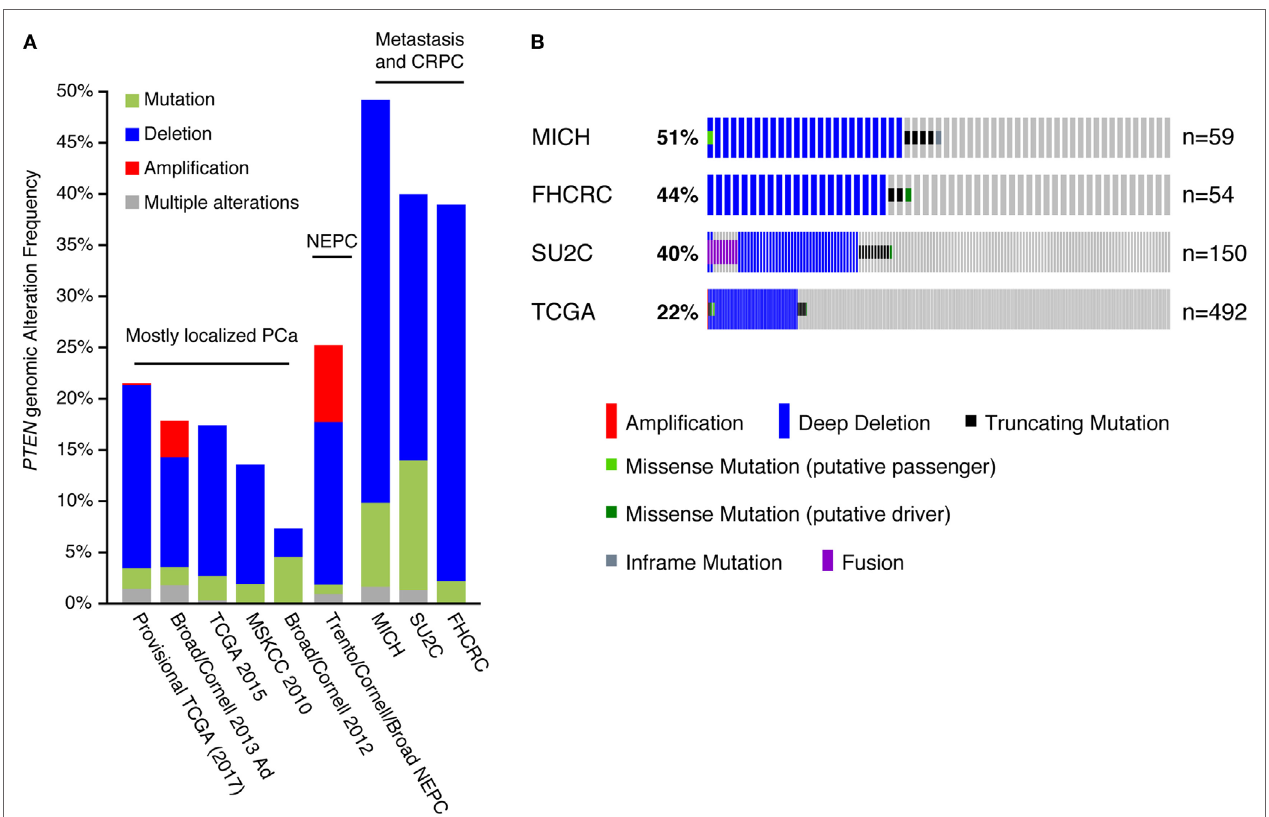
FiGUre 2 | Copy number alteration (CNA) is the most frequent inactivation mechanism of PTEN in human prostate cancer (PCa). (A) Genomic alterations of the PTEN gene in PCa. Only cohorts with data on both mutation and CNAs are shown. Abbreviations: NEPC, neuroendocrine prostate cancer; CRPC, castration- resistant PCa. (B) Specific alterations of PTEN in the Michigan (MICH), Fred Hutchinson Cancer Research Center (FHCRC), Stand Up To Cancer (SU2C), and The Cancer Genome Atlas (TCGA) cohorts. Note that the proportion of alterations is slightly different than in (A) : all tumors are shown in (A) while all patients are shown in (B) (some patients had more than one sample